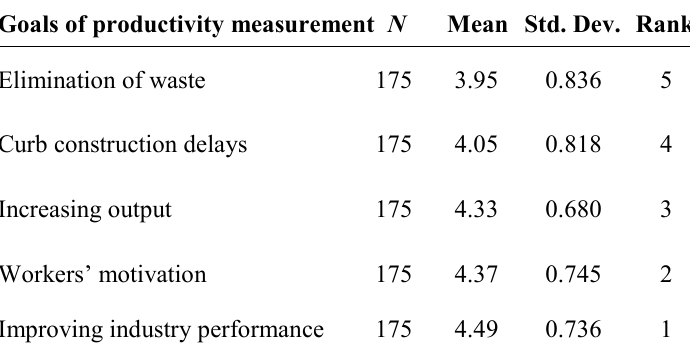
Table 1. Reasons for Productivity